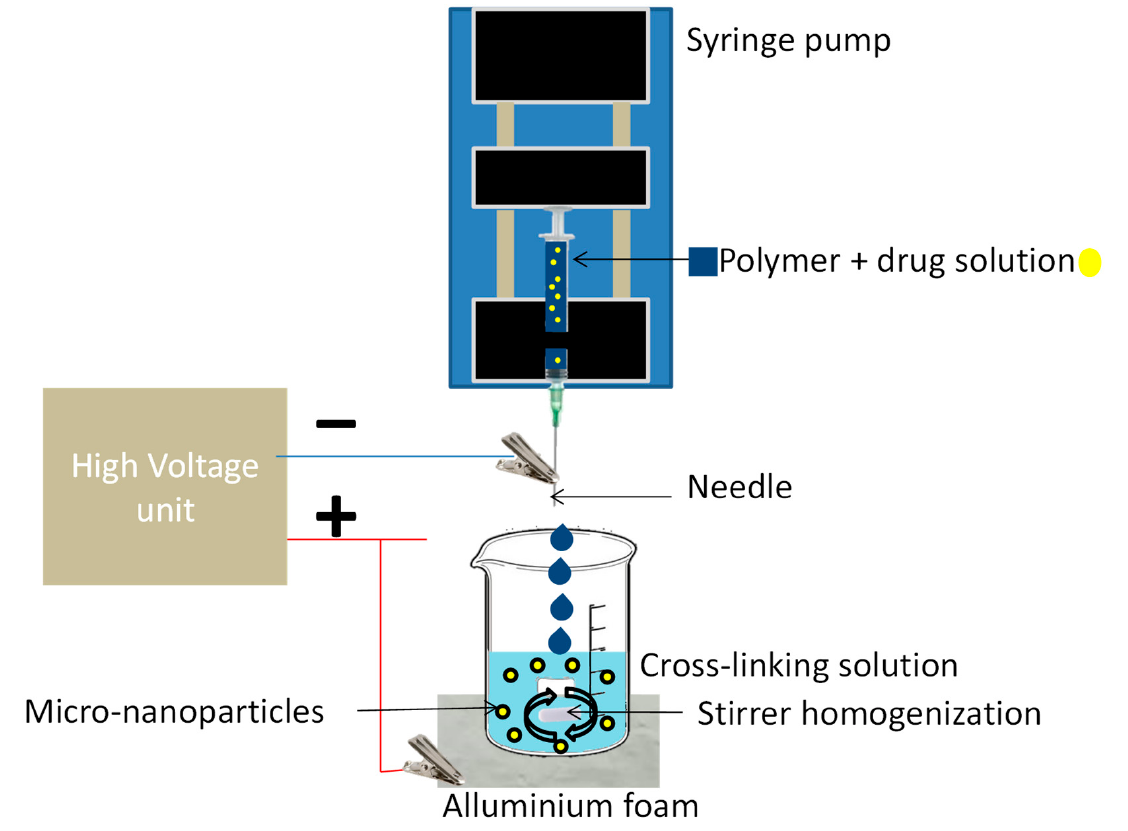
Figure 1. Encapsulation using electrospray techniques.